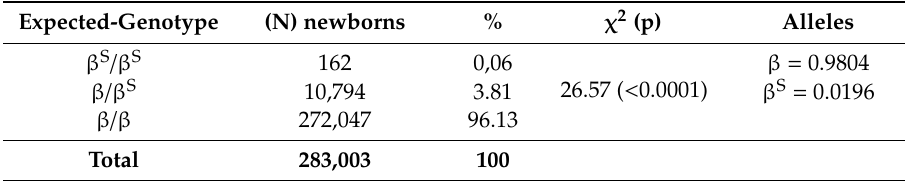
Table 4. Distributions of sickle cell anaemia expected-genotypes in newborns identified in the databases and the numbers and percentage of cases according Chi-square